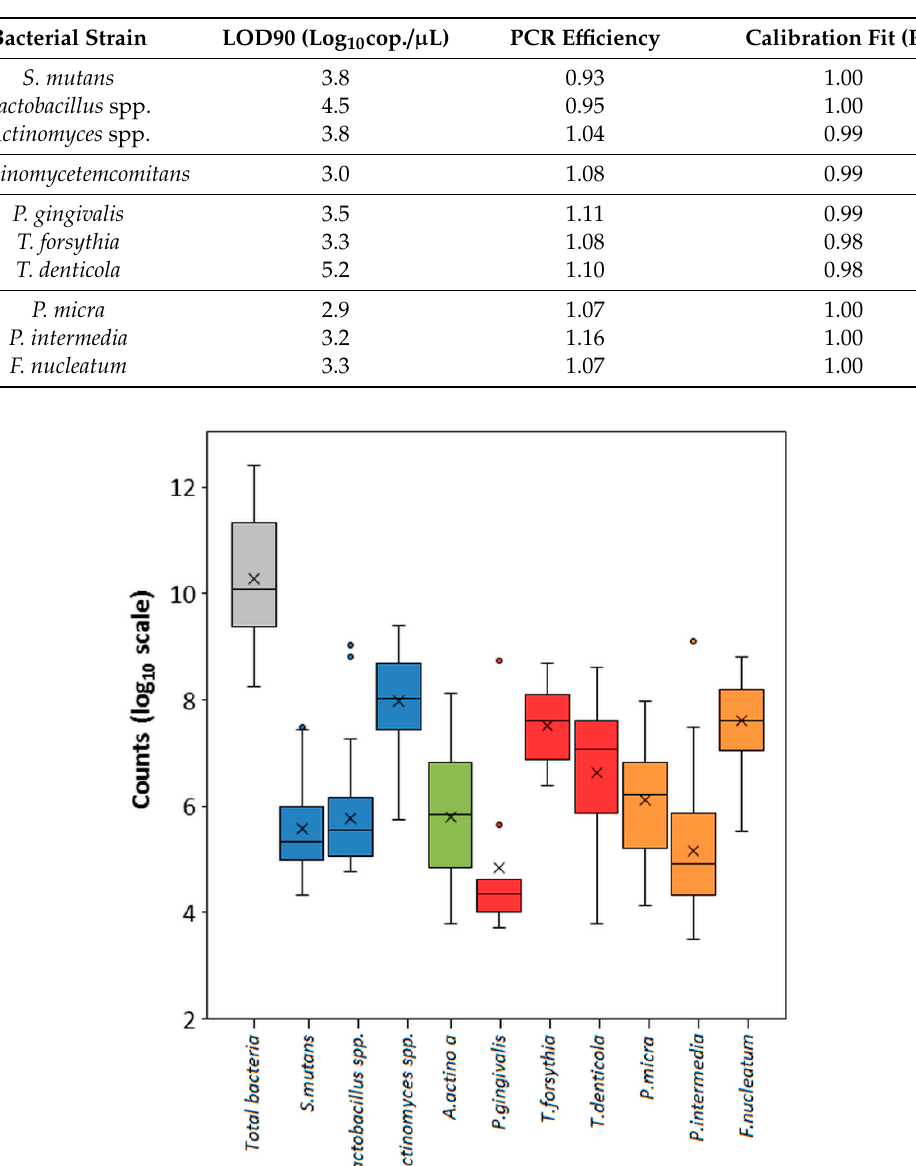
Figure 1. Abundance of bacterial species among the tested interdental site samples. The counts are reported on a log 10 scale. Blue boxes correspond to the subtotals for species of cariogenic bacteria. Red and orange boxes correspond to the subtotals for species of the Socransky red and orange complexes.